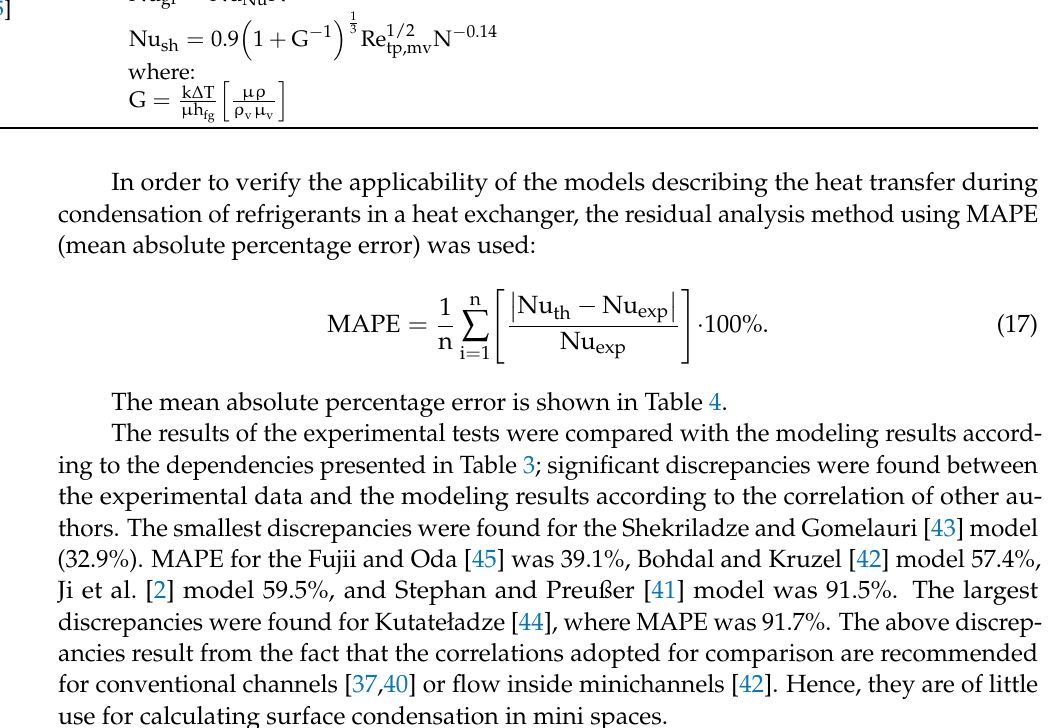
Table 4. Comparison of the results of experimental research and calculations according to the correlations of various authors in the form of mean absolute percentage errors (MAPE) for